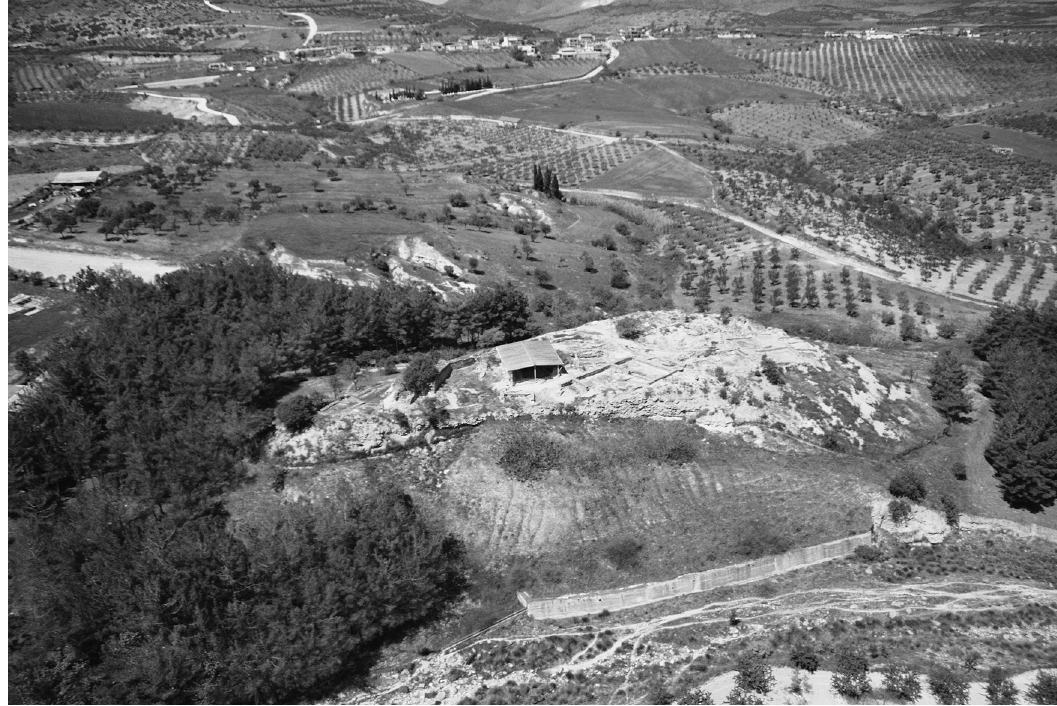
Figure 2: The tell of Sesklo and surrounding landscape from the southwest, aerial photograph ( Copyright: Vassiliki Adrimi - Sismani ) .